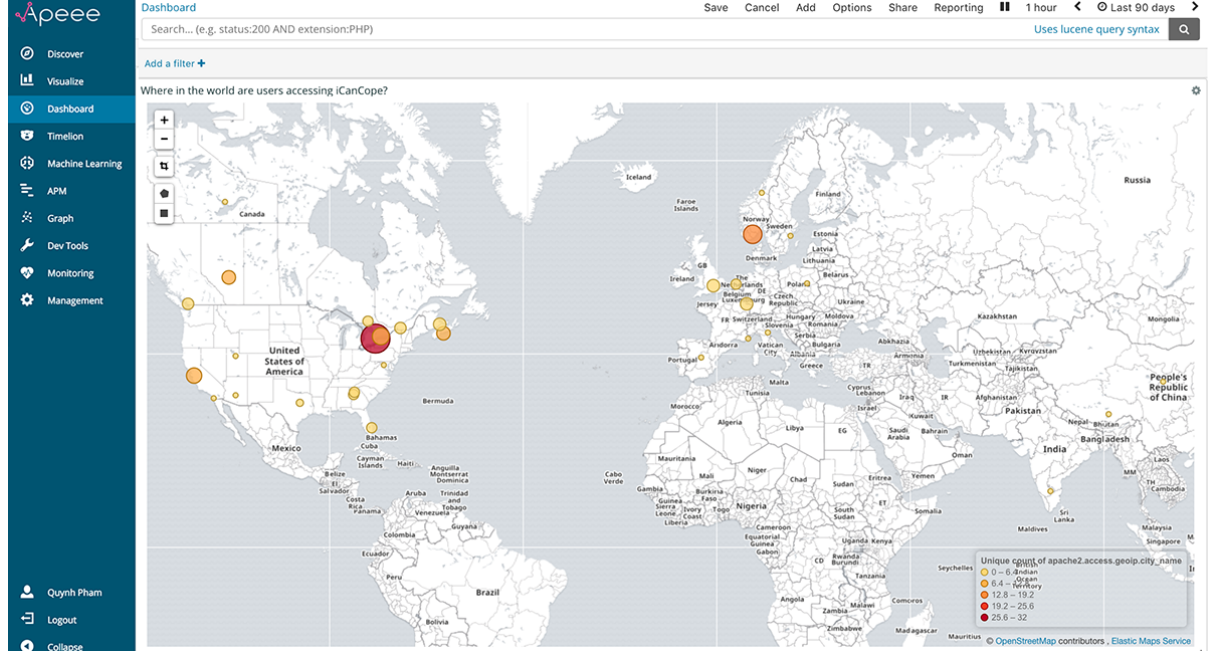
Figure 3. The analytic indicator for “where in the world are users accessing iCanCope?,” visualized through APEEE as a choropleth map covering 5 continents. APEEE: Analytics Platform to Evaluate Effective Engagement.